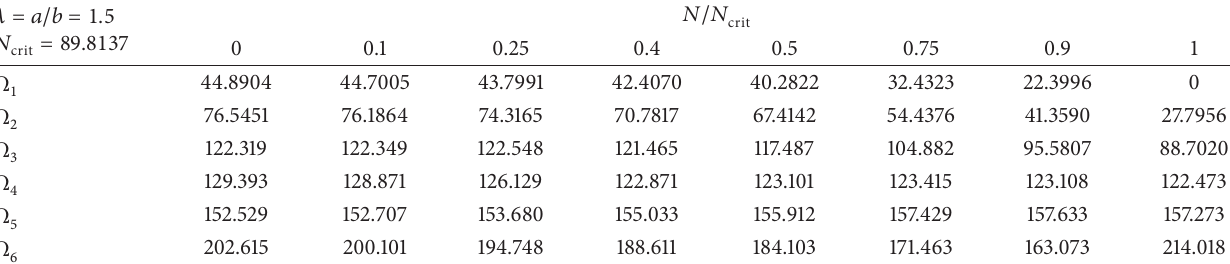
Table 3: The first six natural frequency coefficients Ω 𝑖 for a C-C-SS-SS plate under uniform shear 𝑁 𝑥𝑦 loading.